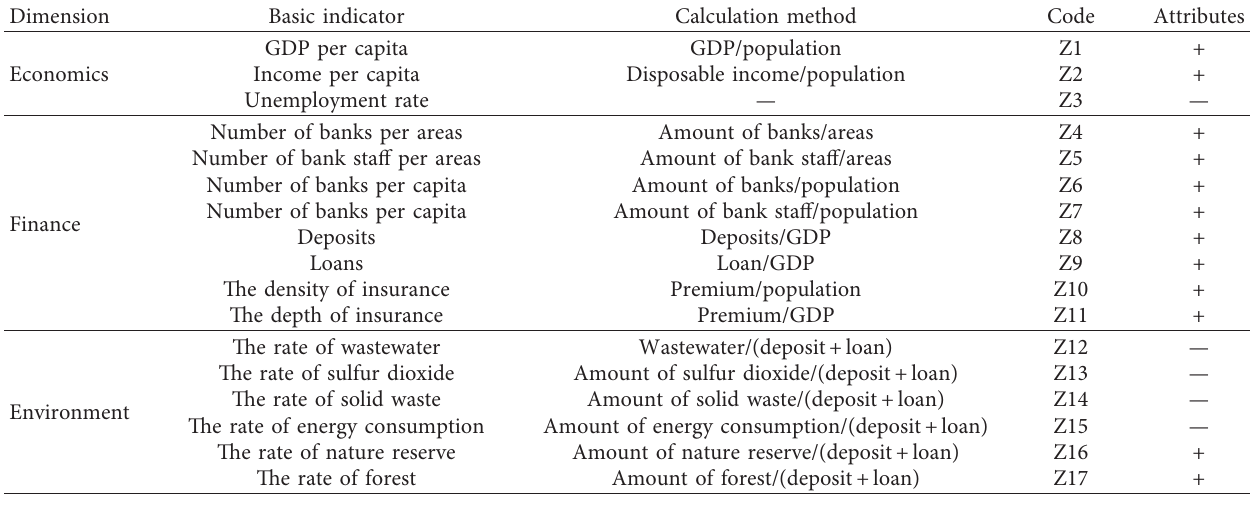
Table 1: Relevant indicators of green finance